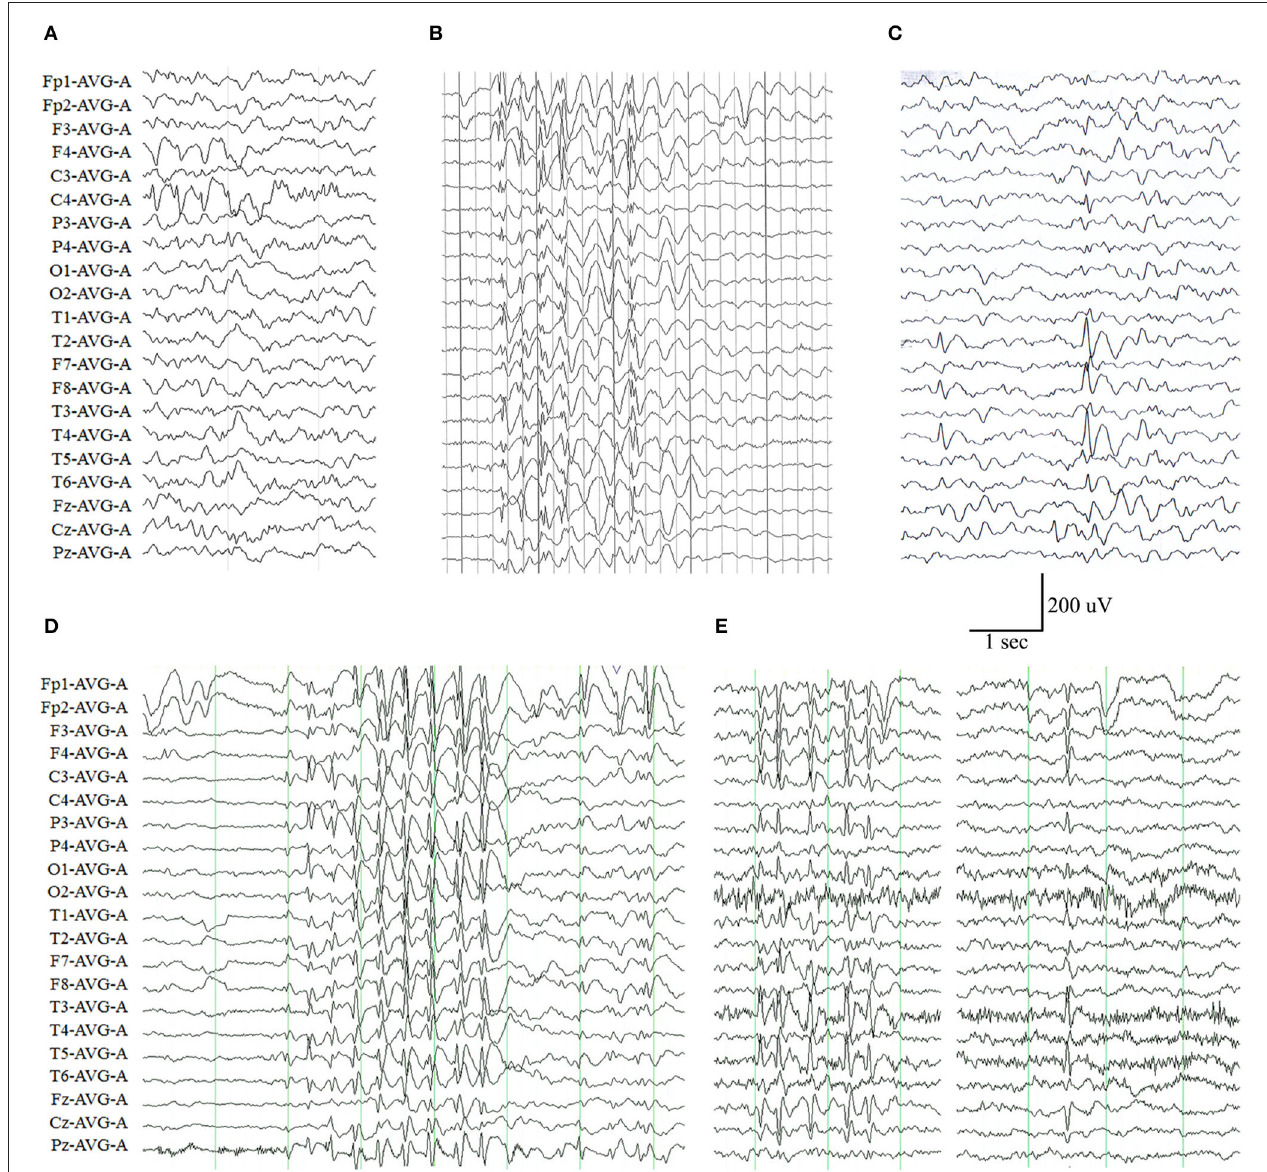
FIGURE 2 | Electroencephalography (EEG) changes in the cases with ADGRV1 variants. (A) Interictal EEG of case 1 at the age of 4 months showed spike-slow waves in the posterior right frontal and central lobes. (B) Interictal EEG of case 2 at the age of 6 years showed irregular generalized spike-slow waves. (C) Interictal EEG of case 3 at the age of 11 years showed spike-slow waves in the right temporal lobe. (D) Interictal EEG of case 6 at the age of 5 years showed asymmetric generalized spike-slow waves. (E) Interictal EEG of case 9 at the age of 8 years showed irregular and asymmetric generalized spike-slow